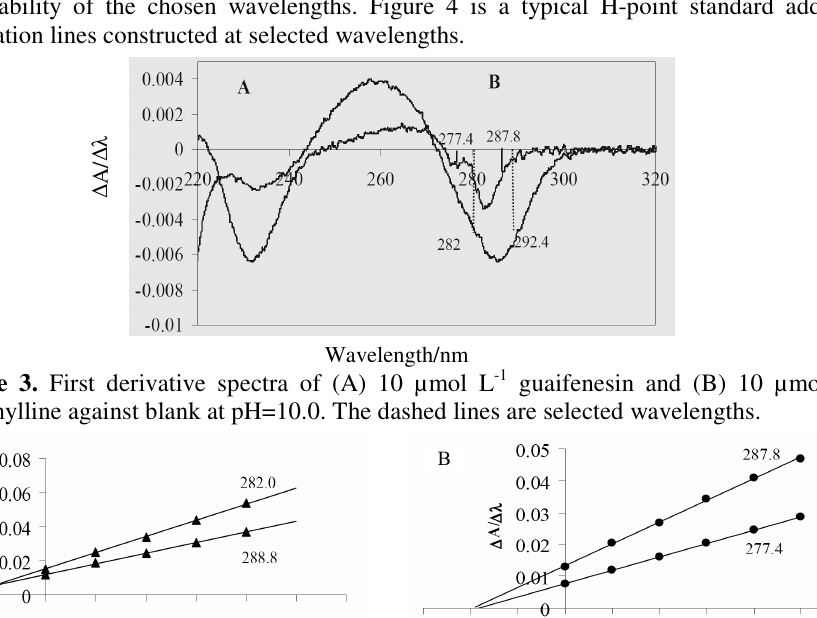
G added / µ mol L -1 T added / µ mol L -1 Figure 4. H-point standard additions-First Derivative plots for simultaneous determination of (A) guaifenesin (10 µmol L -1 ) and (B) theophylline (20 µmol L -1 ) concentrations at wavelengths 282.0, 290.2 nm and 277.4, 287.8 nm respectively at pH